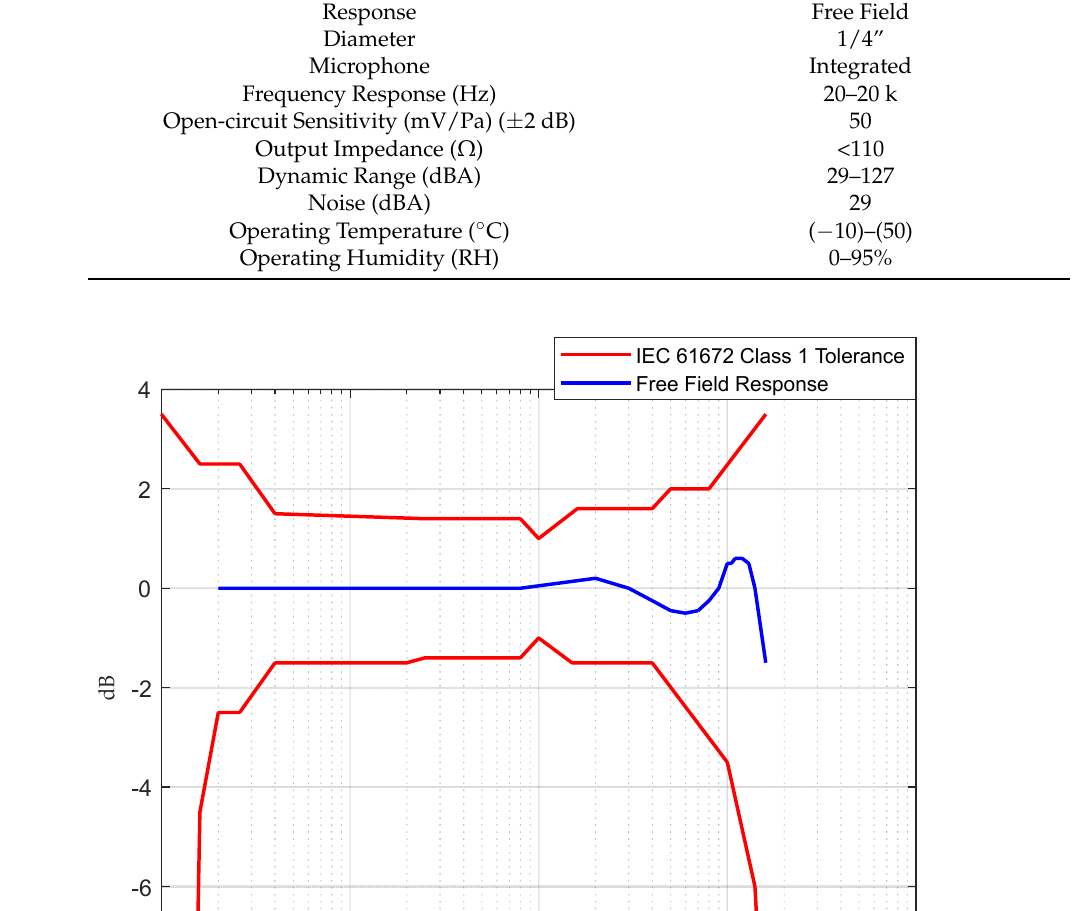
Figure 2. Monitoring system, SAS 2000, in a typical ICU. 4. Results of Data Analysis In this section, the time and frequency domain analyses as well as some statistical approaches of three measured sets of SPLs are presented. All recorded SPLs are in loga- rithmic measures dB.